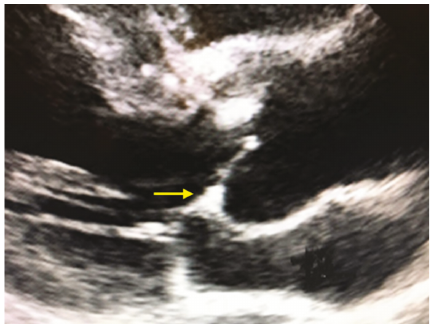
Figure 2: Preoperative transthoracic echocardiography. Apart from a slightly thickened aortic valve (arrow), no clear abnormalities indicative for a hemangioma could be observed.